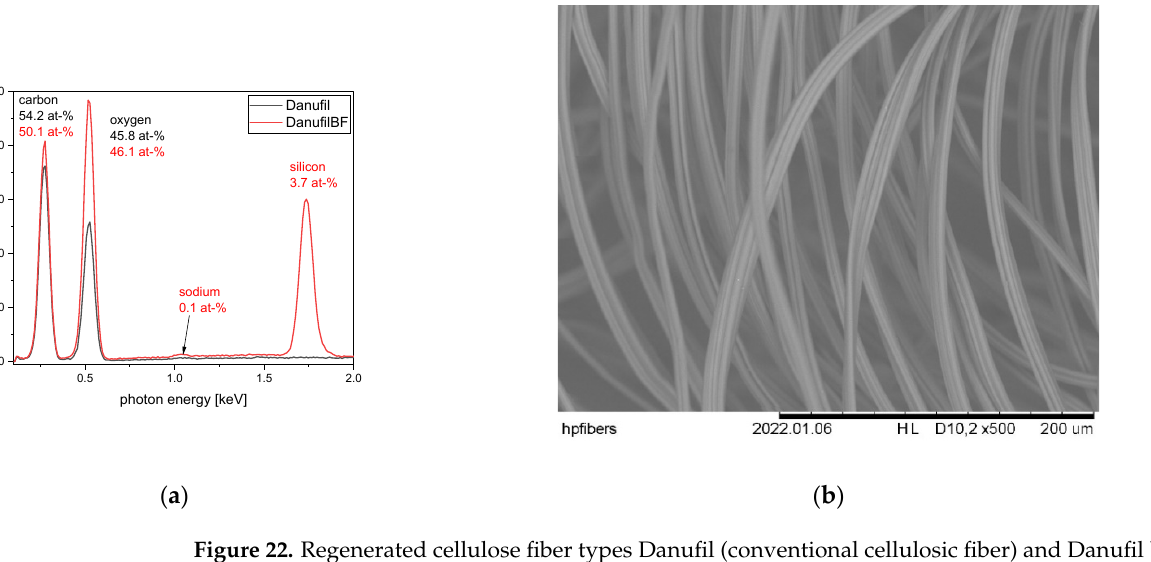
( b ) Figure 21. Commercially available fabric made from functional polyester TreviraCS—( a ) EDS spec- trum; ( b ) SEM image. While polyester fibers are modified with phosphorous compounds to reach flame- retardant properties, regenerated cellulose fibers can be modified with silicon compounds for the same reason [105,106]. One example of such a product is the fiber Danufil BF sup- plied by Kelheim Fibers. Compared to the analogous conventional cellulosic fiber from the same producer (type: Danufil), Danufil BF is modified by the addition of a silicon ox- ide-based component to the spinning mass. Due to the absence of other chemical elements,